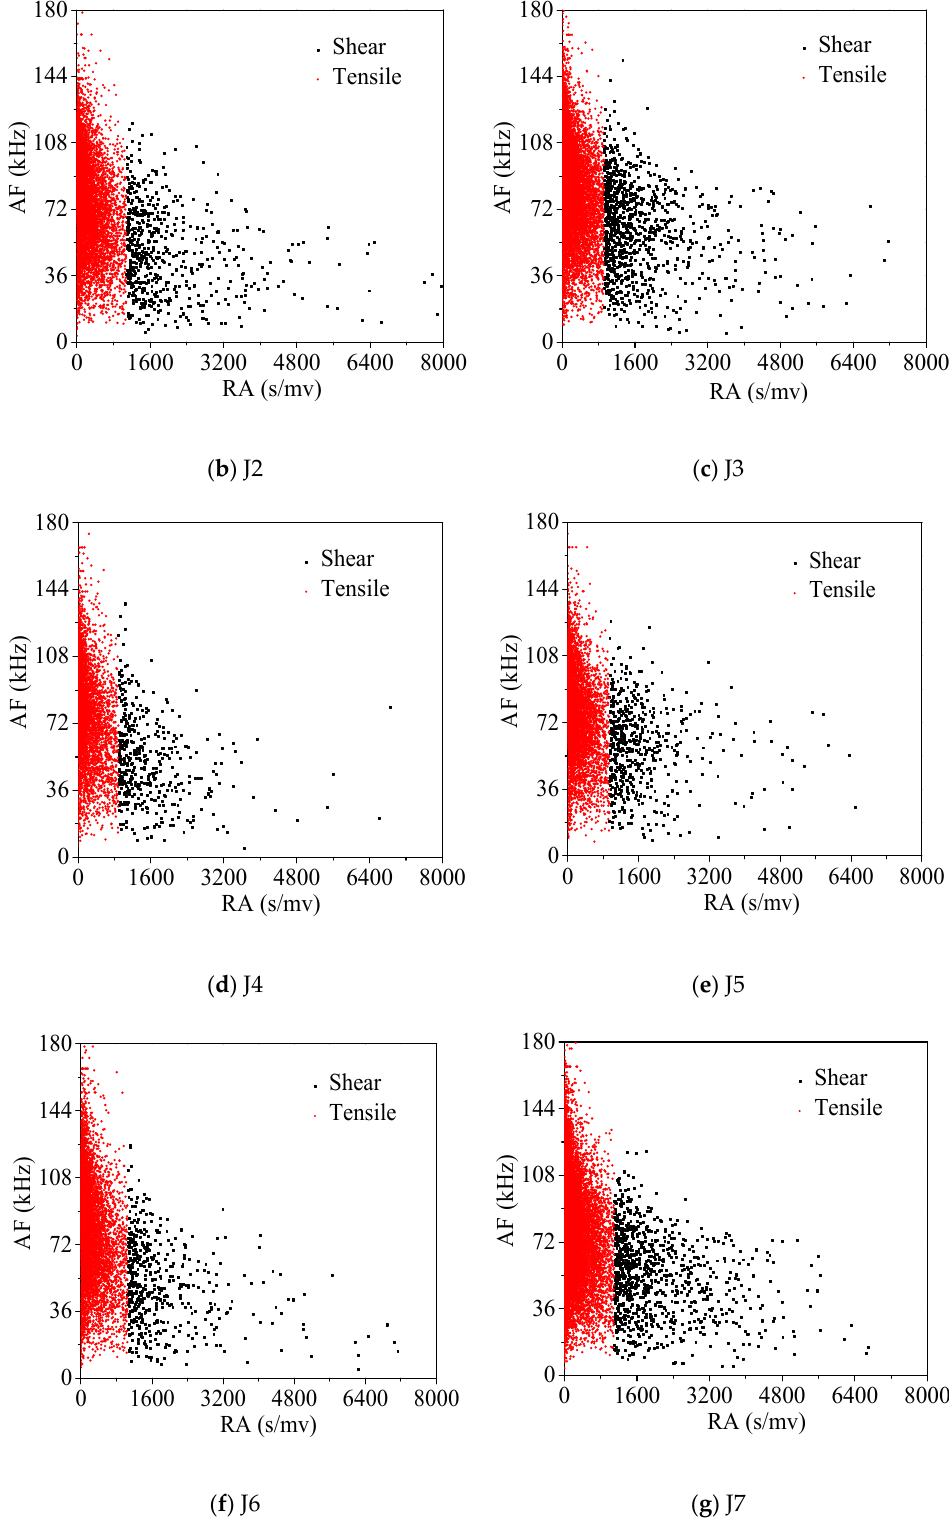
Figure 11. Concrete SPSS shear-tensile failure calculation results.